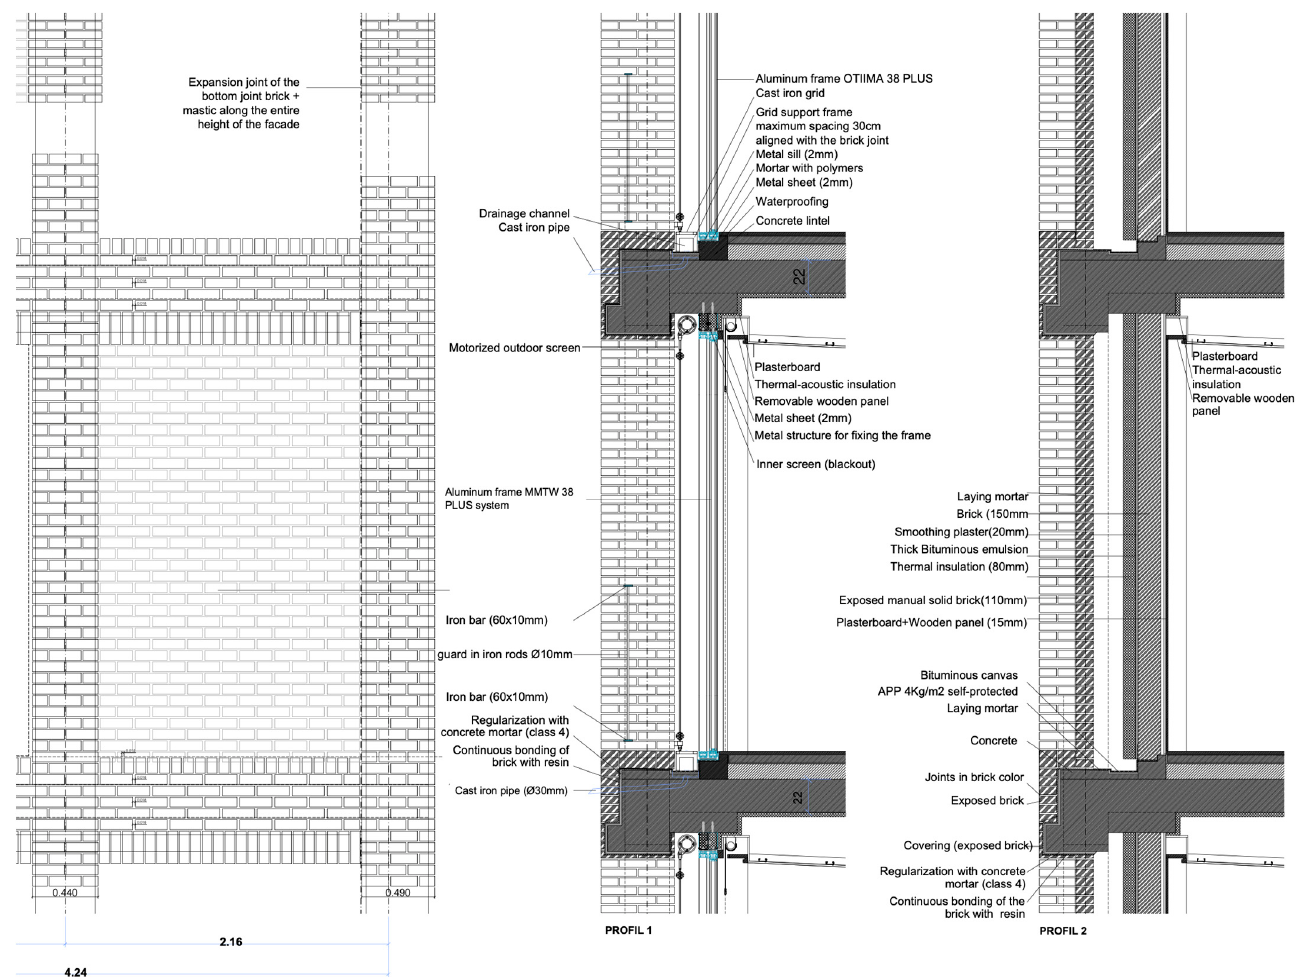
Figure 29. Vila Nova de Gaia. Construction section.